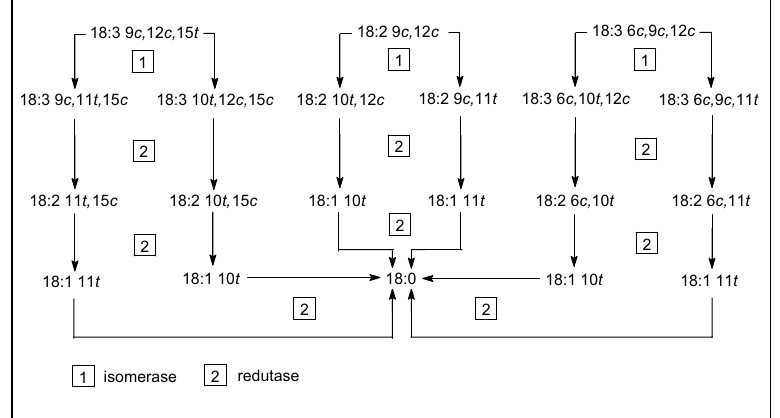
Fig. 3 – Formation of acids 18:1 11 t and 18:1 10 t in ruminants from linoleic, alpha- linolenic, and gamma-linolenic acids (adapted from Khanal and Dhiman